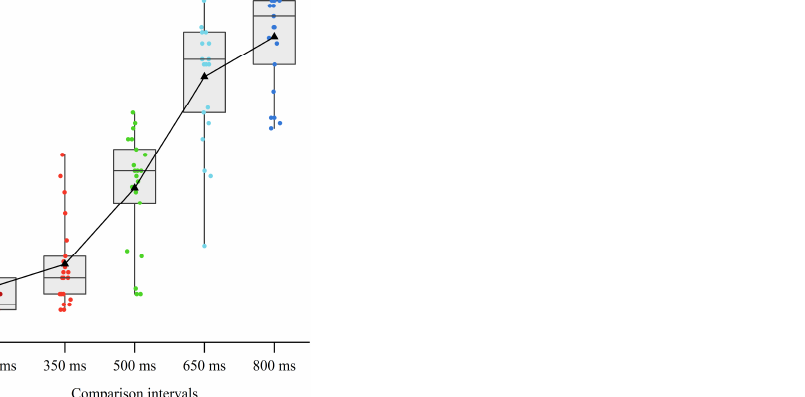
Figure 2. Boxplots of proportion of “Long” response in Experiment 1. The black triangles indicate mean values.